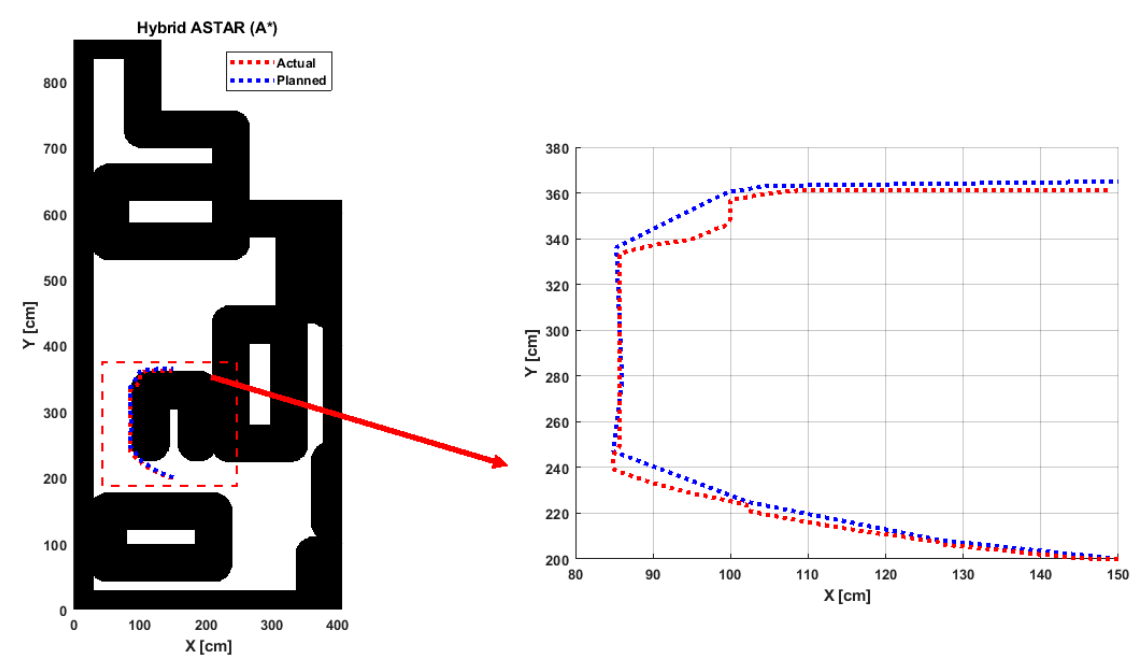
Figure 17. The experimental path that is generated by using Hybrid A* in Map3. The blue line is the planned path, while the red line is the actual path.